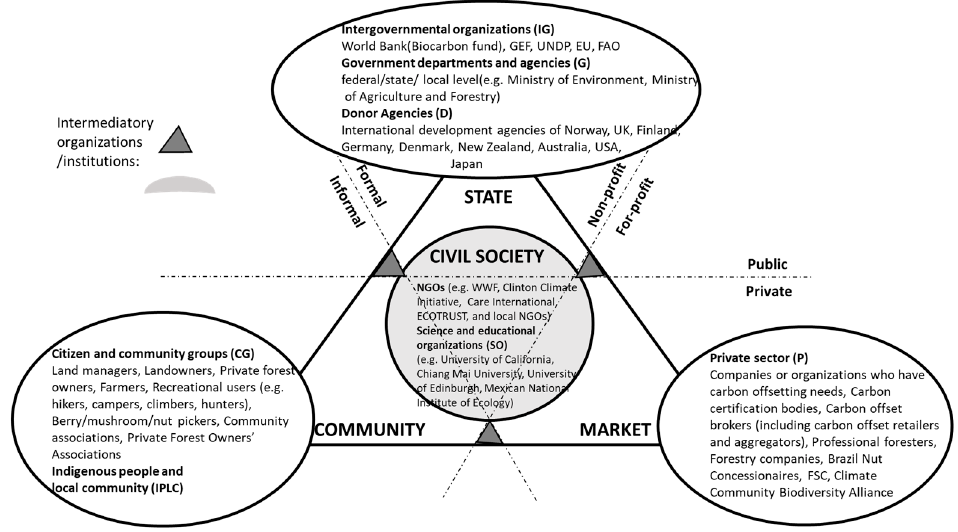
Figure 4. Actor categories identified in the review from a multi-actor perspective (adapted from Avelino & Wittmayer [57] and IPBES [59]).